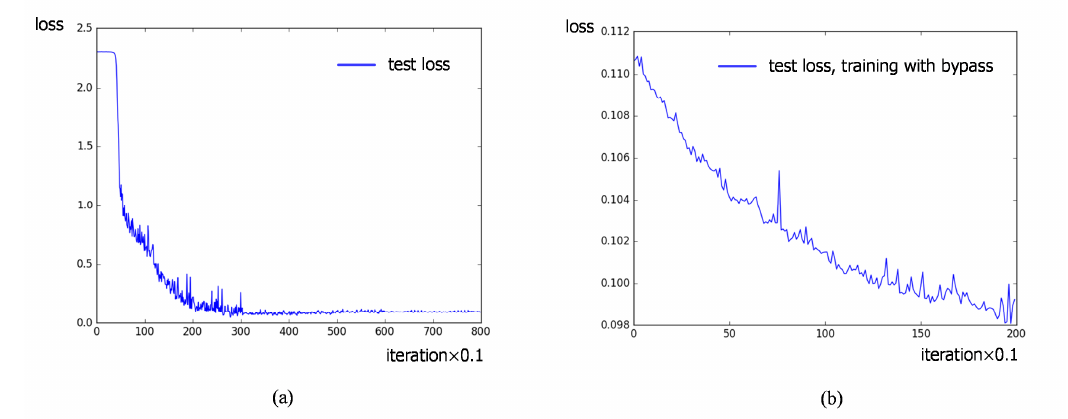
Figure 10. Convolutional layer kernels of baseline and transfer learning. ( a , b ) the kernels in the 1st convolutional layer before and after transfer learning; ( c , d ) the kernels in the 3rd convolutional layer before and after transfer learning.